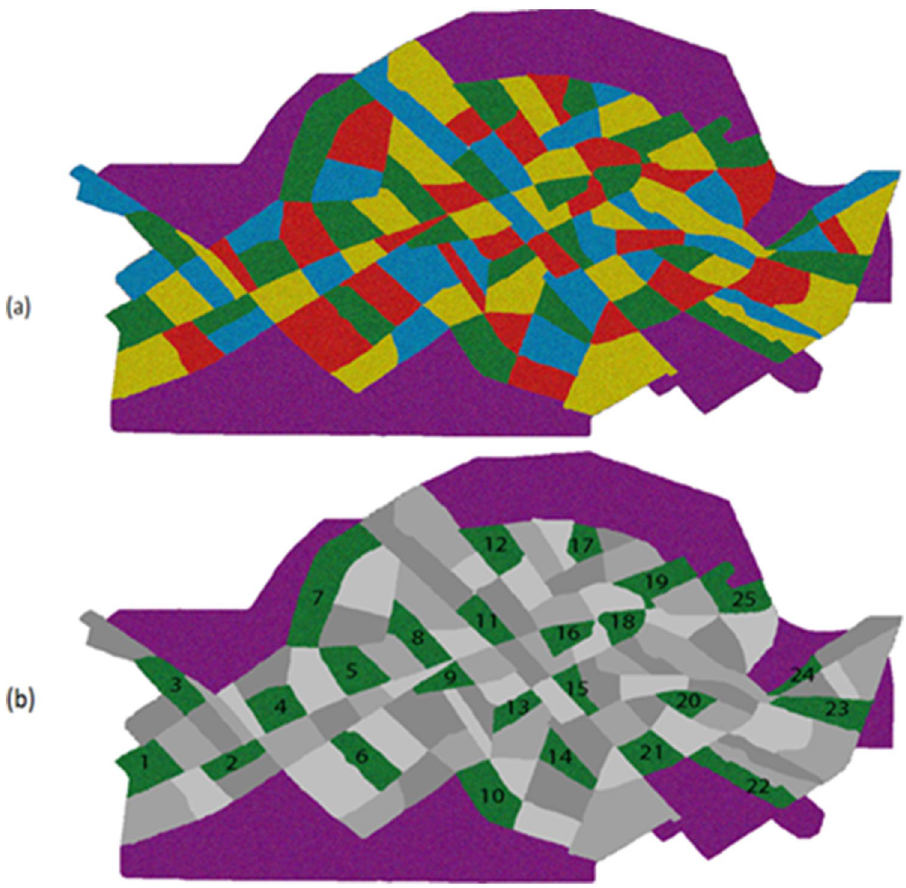
Figure 1. ( a ) Schematic representation of the suburbs and city of Kerman, Iran, showing the city divided into 100 blocks. ( b ) All selected green and purple blocks indicate the areas selected for street survey using sight- resight method for free-roaming dog population